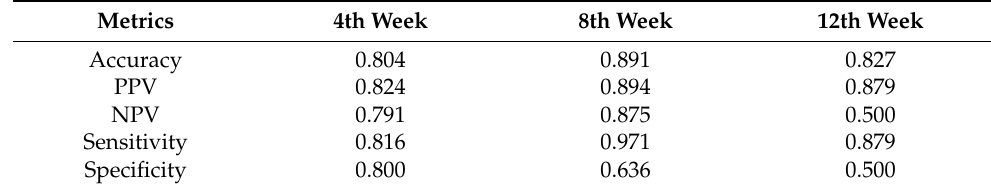
Table 2. Performance of the best ML models predicting clinical outcome of the canine lymphoma patients treated with the (L-)CHOP